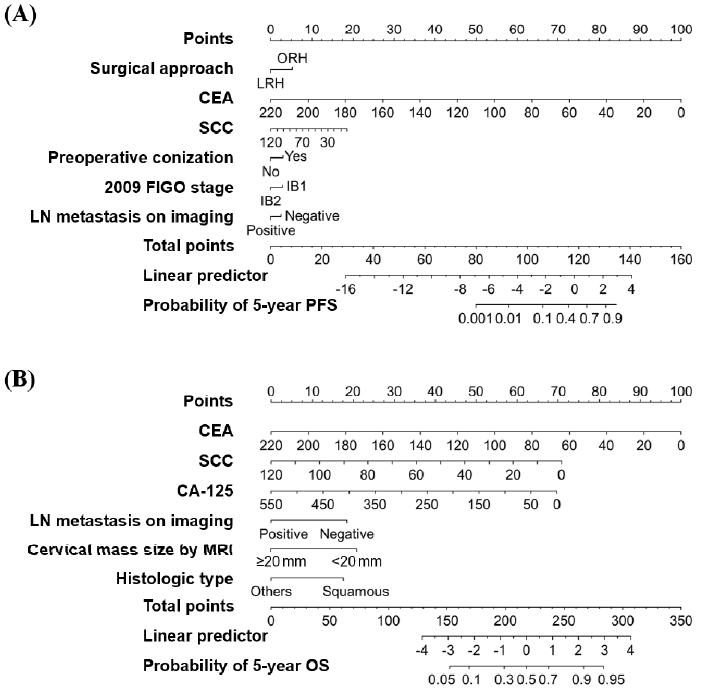
Figure 5. Logistic-regression-based nomograms predicting probabilities of ( A ) 5-year PFS and ( B ) 5-year OS.